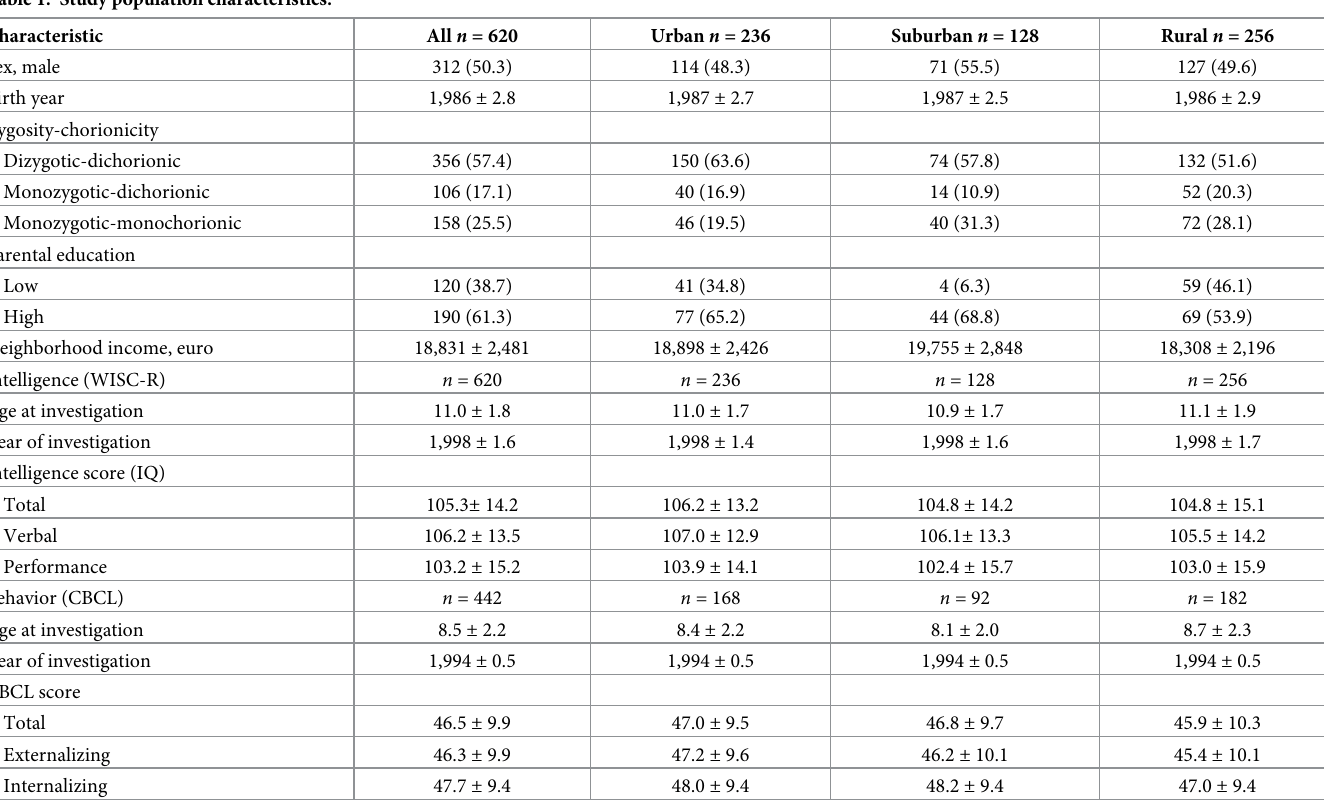
Table 1. Study population